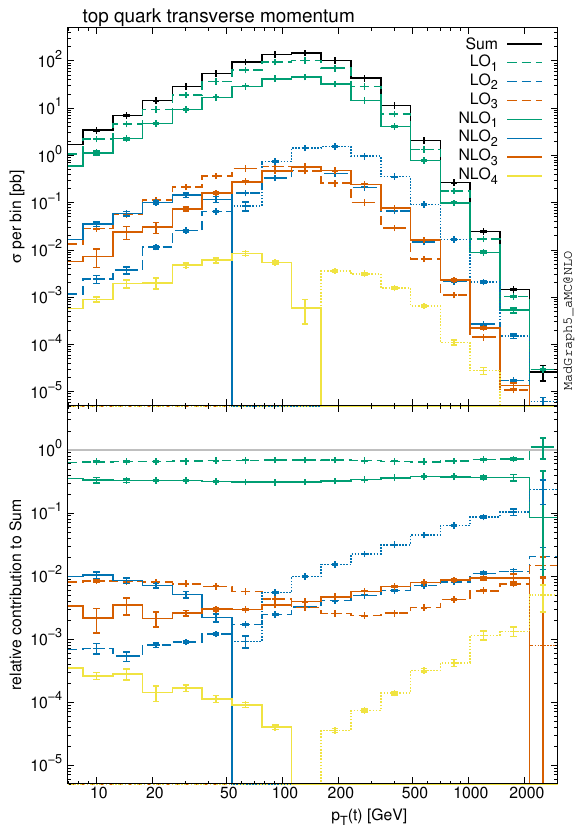
Figure 10. Transverse momentum of the top quark in pp ! t (cid:22) t